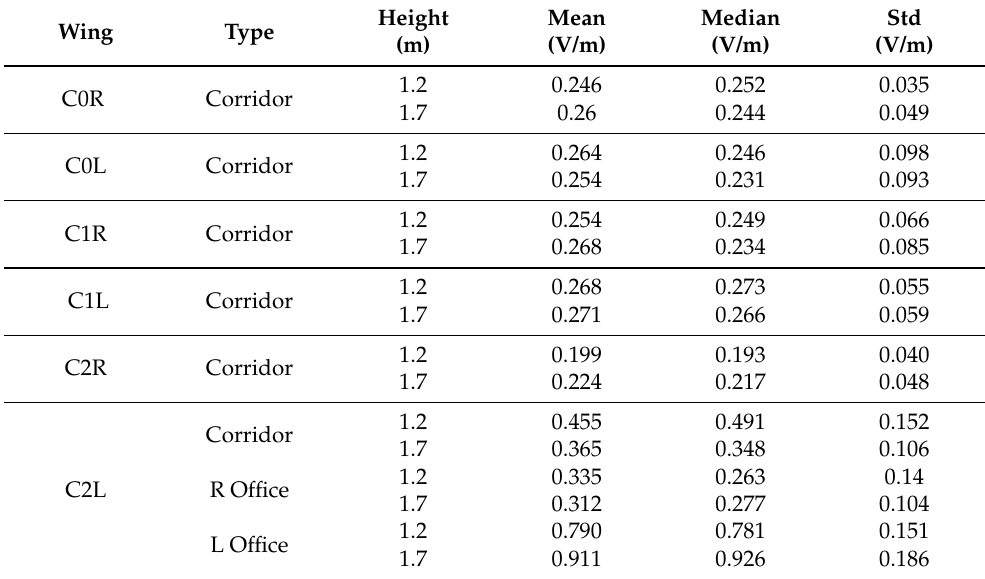
Table 4. Mean, median, and standard deviation of two height measurements for building C.